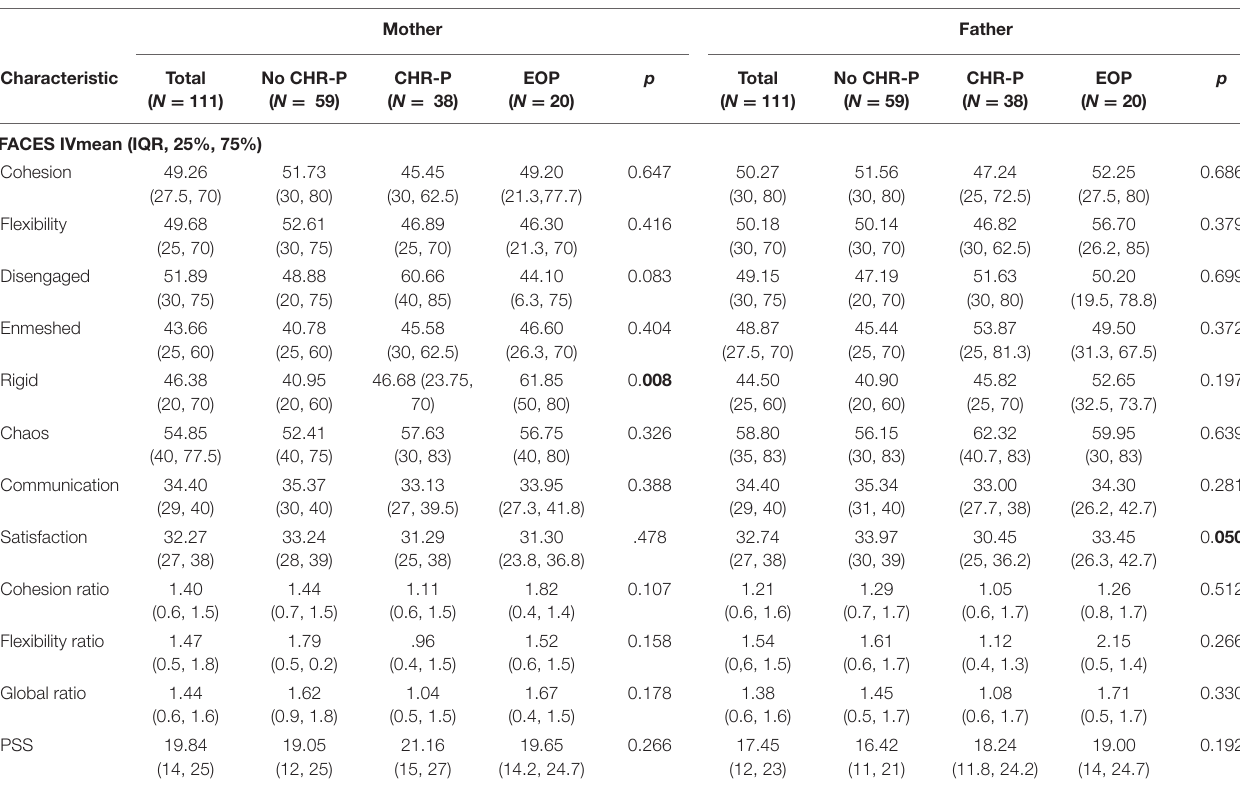
TABLE 2 | Results of perceived family functioning and stress in both mothers and fathers independently in the whole sample and in the clinical high risk state for psychosis (CHR-P), no CHR-P, and early onset psychosis (EOP) subgroups. Mother Father